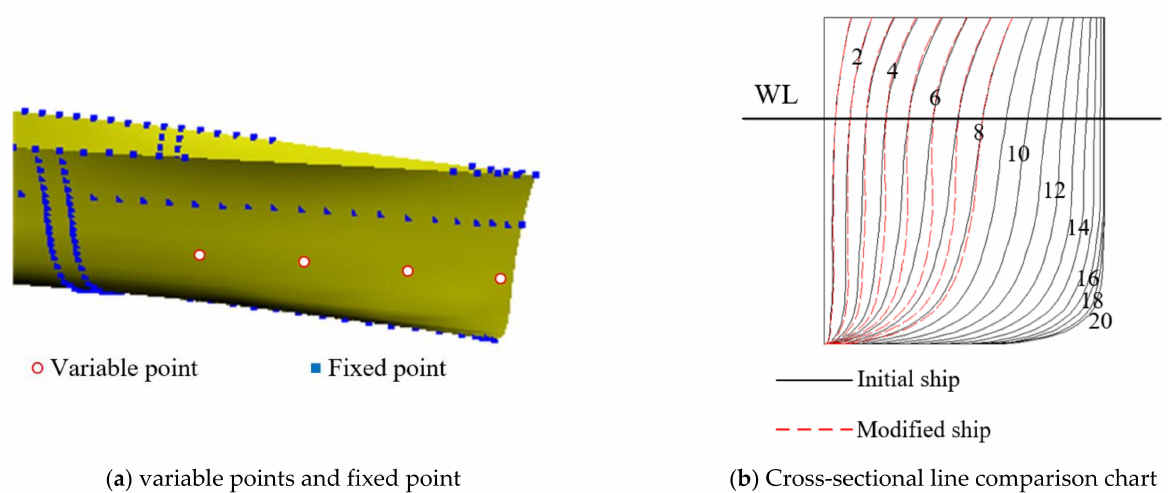
Figure 8. Bow modification with a constrained waterline.